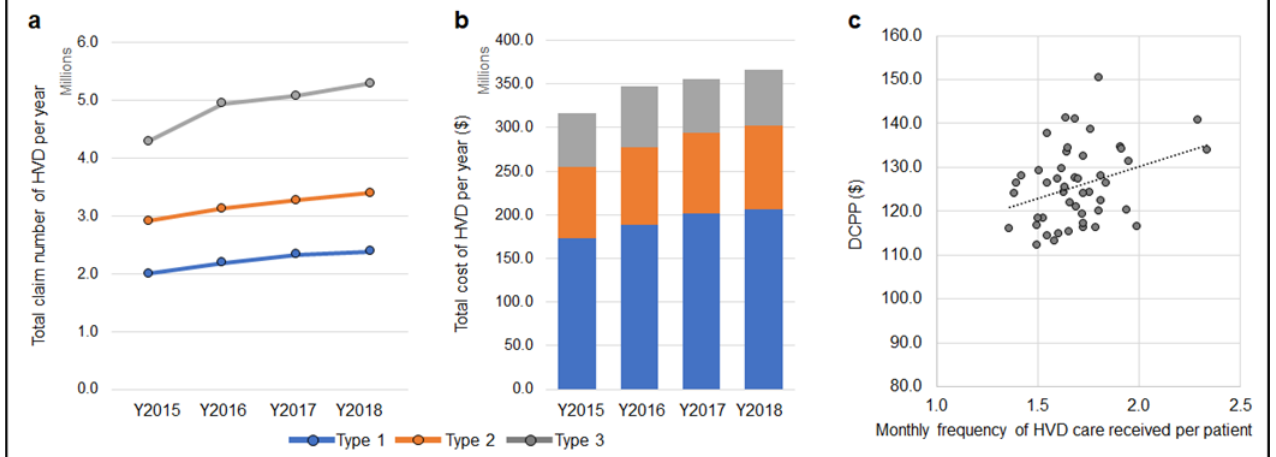
Figure 6. Frequency of HVD (Home Visit Dentistry) and its association with DCPP. ( a ): The fre- quency of HVD type 1, 2, and 3 increased significantly during the four years ( p < 0.01, One-way ANOVA and Tukey HSD test). ( b ): The expenditure of HVD type 1, 2, and 3 increased significantly ( p < 0.01). ( c ): There was a moderate positive correlation between DCPP and monthly frequency of HDV care received per patient (R = +0.319, p < 0.01, Spearman ’ s correlation coefficient).